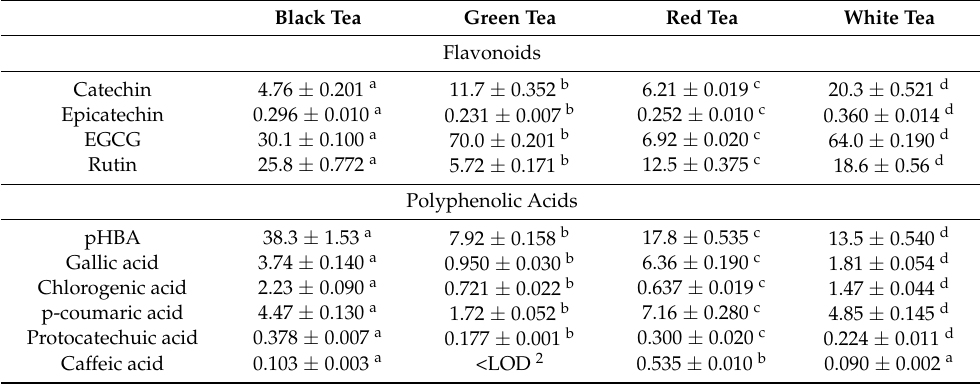
Data are expressed in mg L − 1 of tea and as the means ± SD of three independent experiments. Different letters in each row indicate a difference at a significance level of p = 0.05. 2 LOD—limit of detection—the